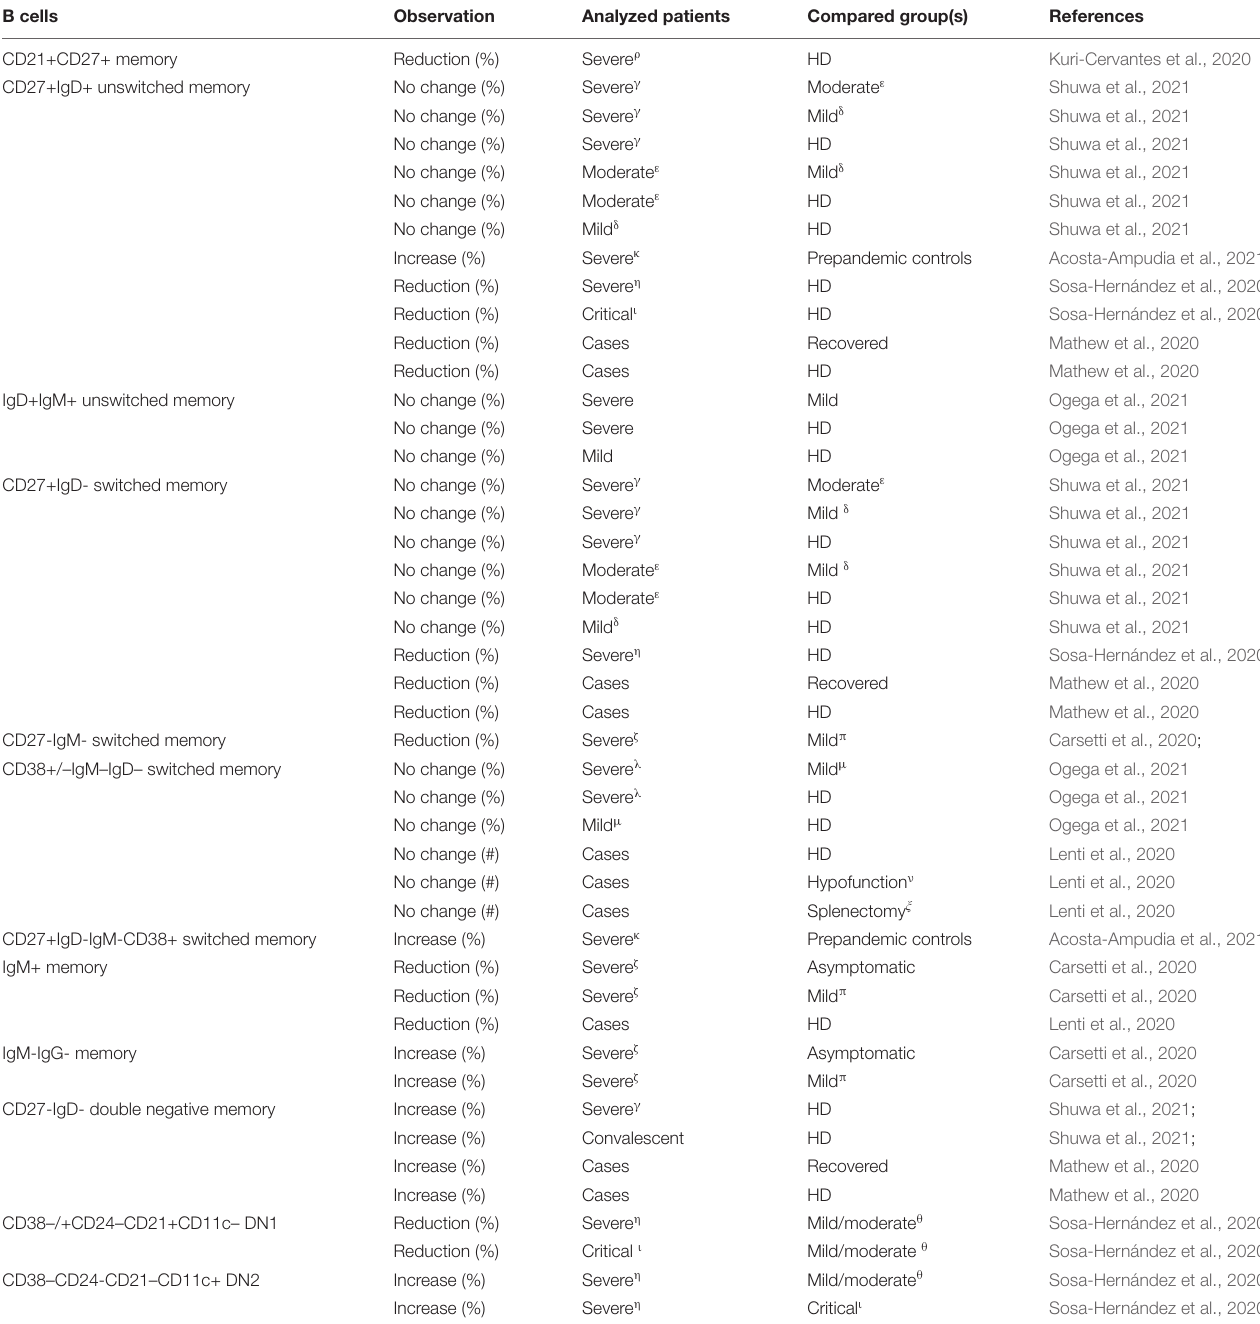
TABLE 7 | Observed fluctuation in B cells in adult COVID-19